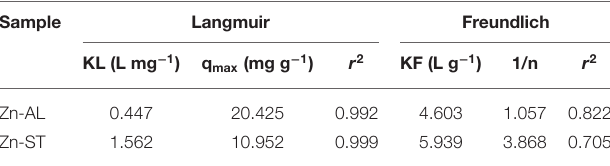
TABLE 1 | Parameters of the Langmuir isotherms and the Freundlich for adsorption of Cu (II) ions into ZnO samples. Sample Langmuir Freundlich